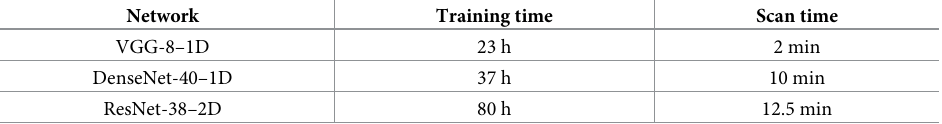
Table 5. Time resources: Tcime of a network training on the fully-augmented VOC dataset and scanning time of a single GC-MS sample.